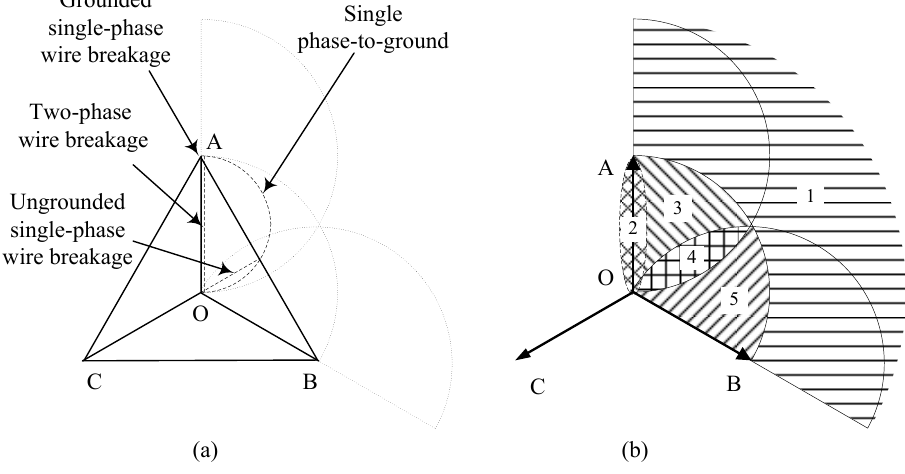
Figure 12. ( a ) Possible position of neutral-point voltage in vector graph; ( b ) Divided vector